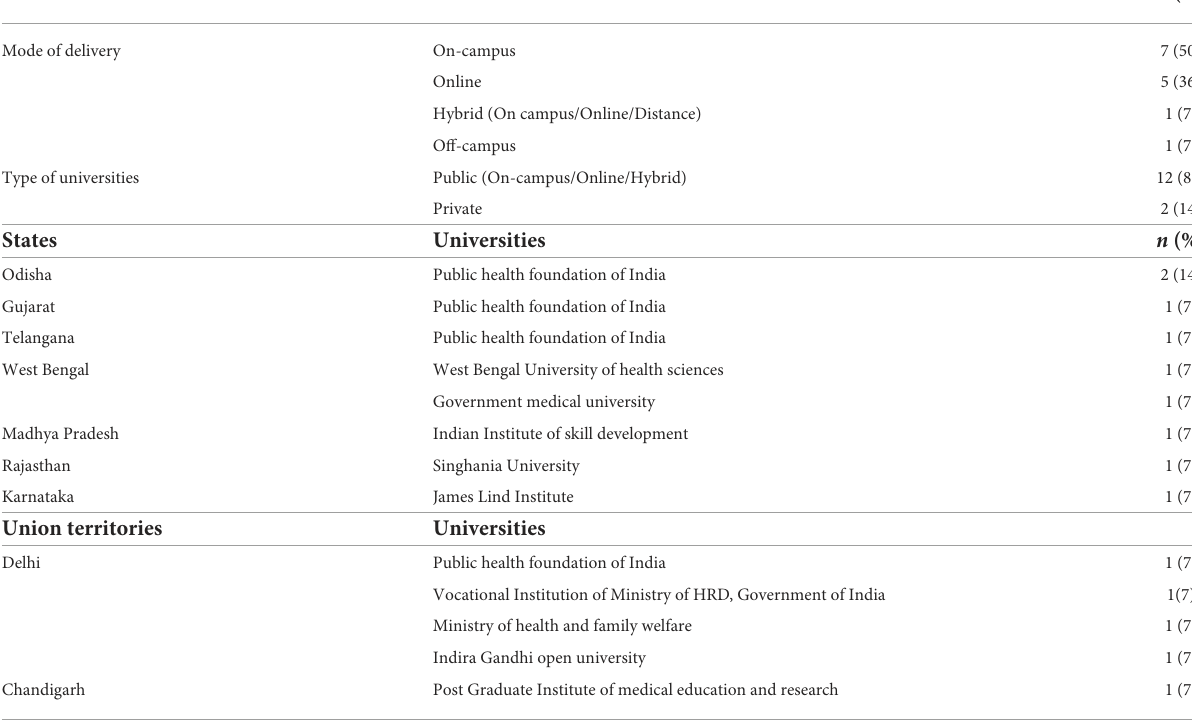
TABLE 6 Frequency of PGD programs provided by universities in the different states ( N = 14). Parameters